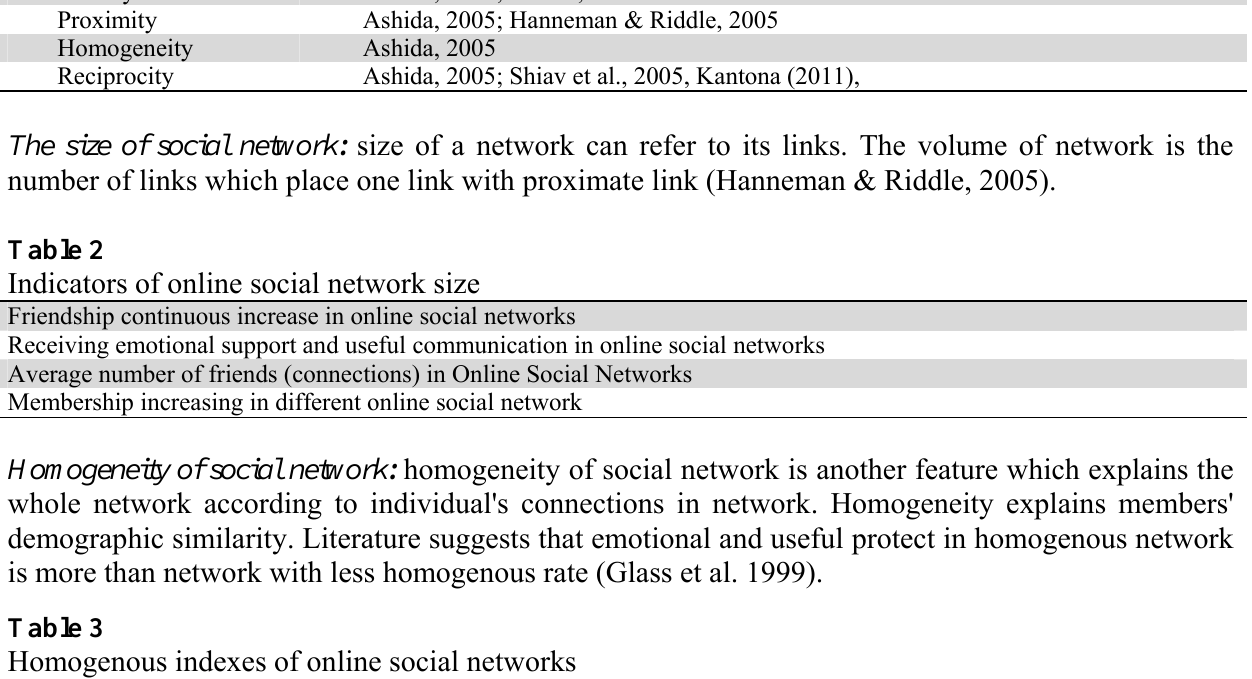
Criteria of Online Social Networks Factor Reference Size Ashida, 2005; Hanneman & Riddle, 2005; Kantona (2011) Frequency Ashida. 2005 Density Ashida, 2005; Martin, 2012 Proximity Ashida, 2005; Hanneman & Riddle, 2005 Homogeneity Ashida, 2005 Reciprocity Ashida, 2005; Shiav et al., 2005, Kantona (2011),